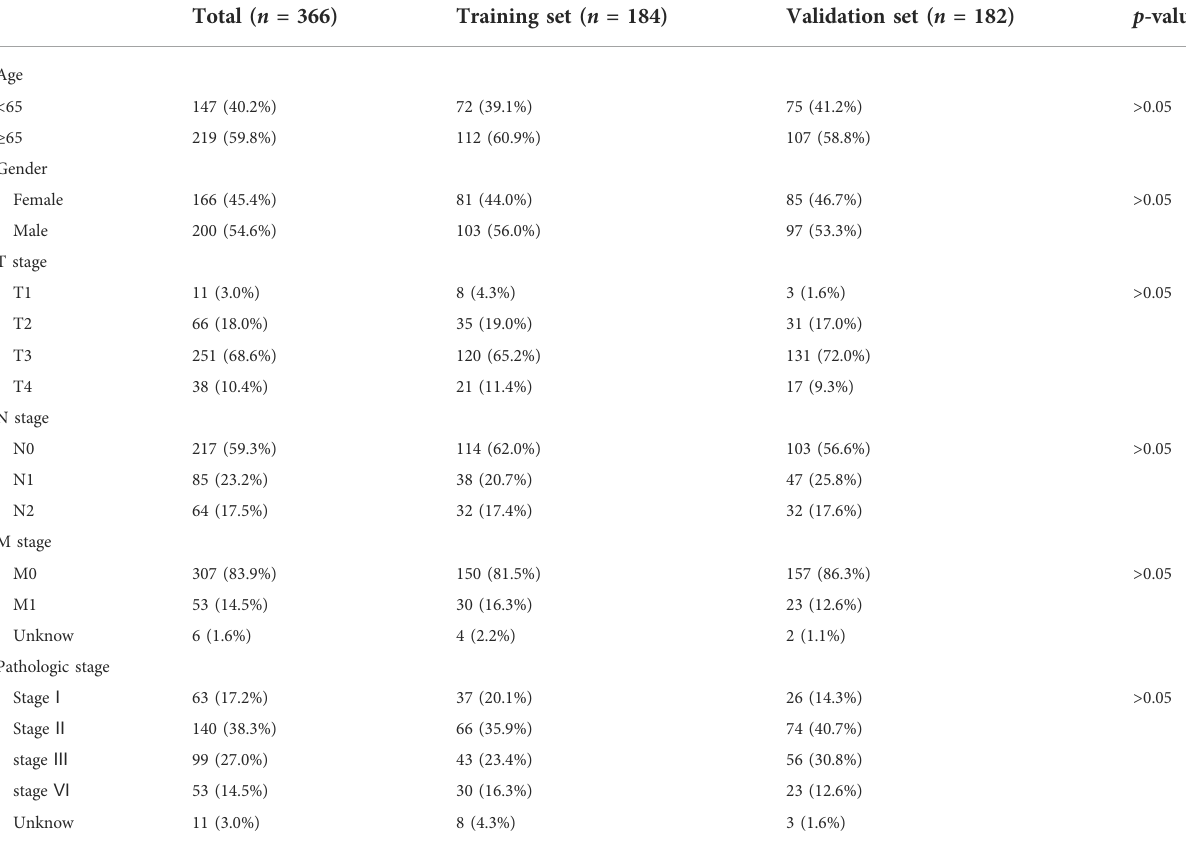
TABLE 1 Characteristics of patients in the training and testing sets.